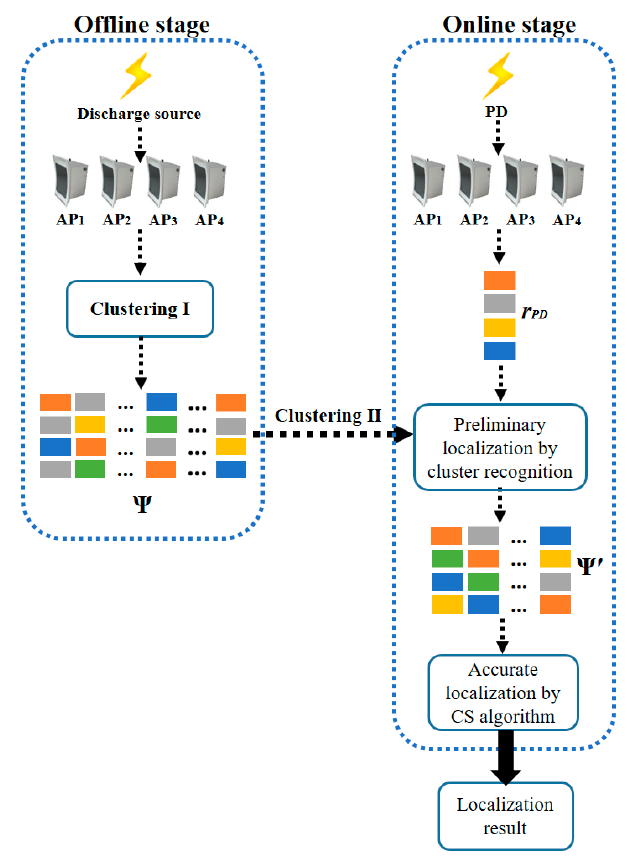
Figure 3. The flow chart of proposed PD localization algorithm.